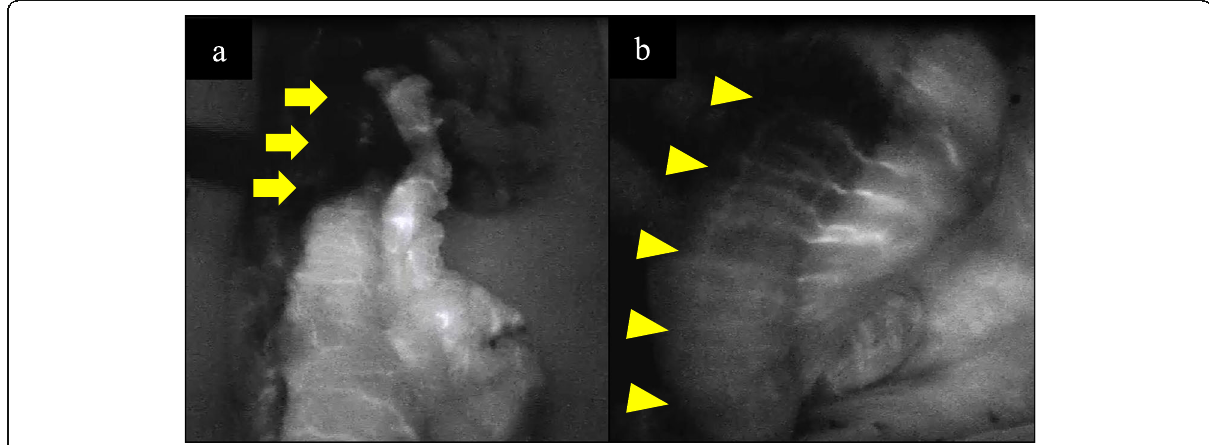
Fig. 4 Estimation of mesenteric blood flow by indocyanine green fluorescence. a The upper gastric tube was not contrasted (arrow). We decided to perform an entire resection of the gastric tube due to this finding in addition to macroscopic and endoscopic findings. b A large part of the small intestine was also not contrasted (arrow head). The segmentally non-contrasted small intestine was resected even if the region can be preserved due to the macroscopic color of the